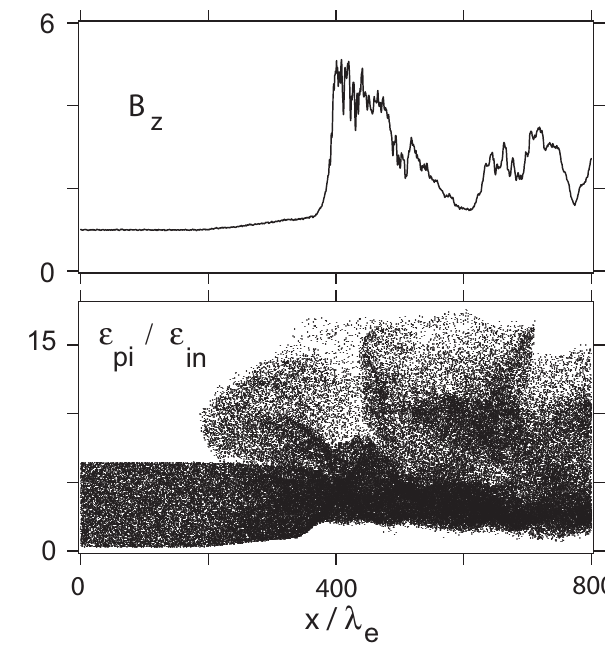
Fig. 8. Magnetic field B z component (top panel) and normalized pickup ion energy (cid:15) pi /(cid:15) in (bottom panel) versus shock normal co- ordinate x